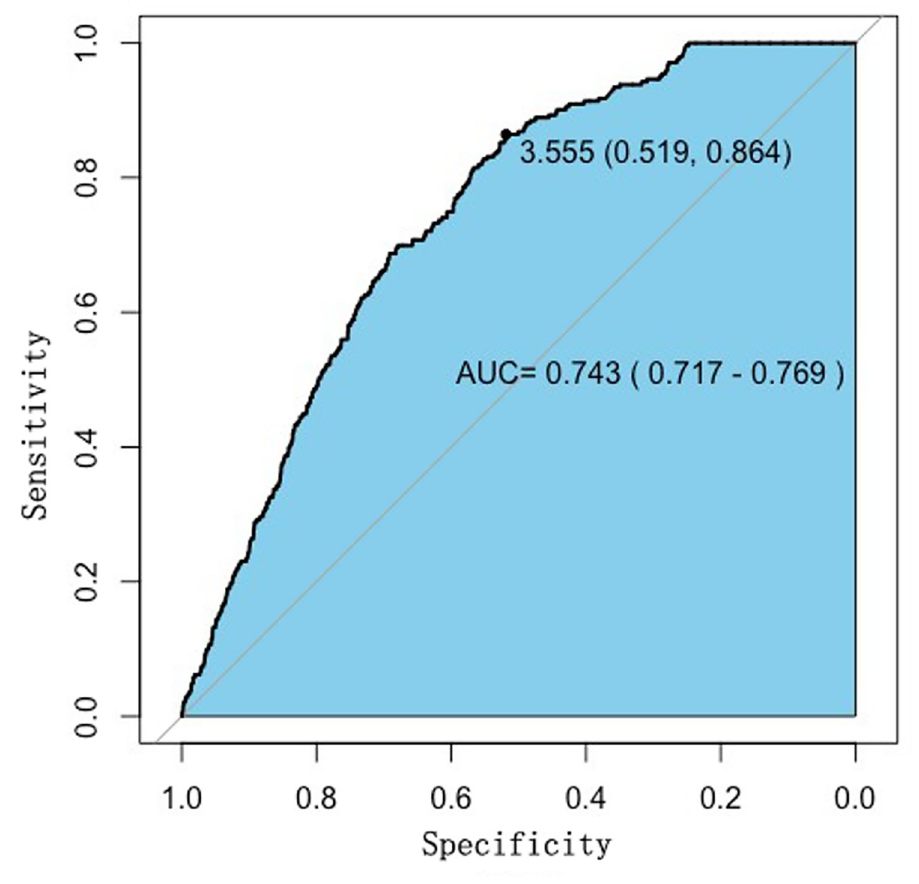
Fig 1. ROC curve analysis of preoperative Neutrophil/lymphocyte ratio for the occurrence postoperative AKI.